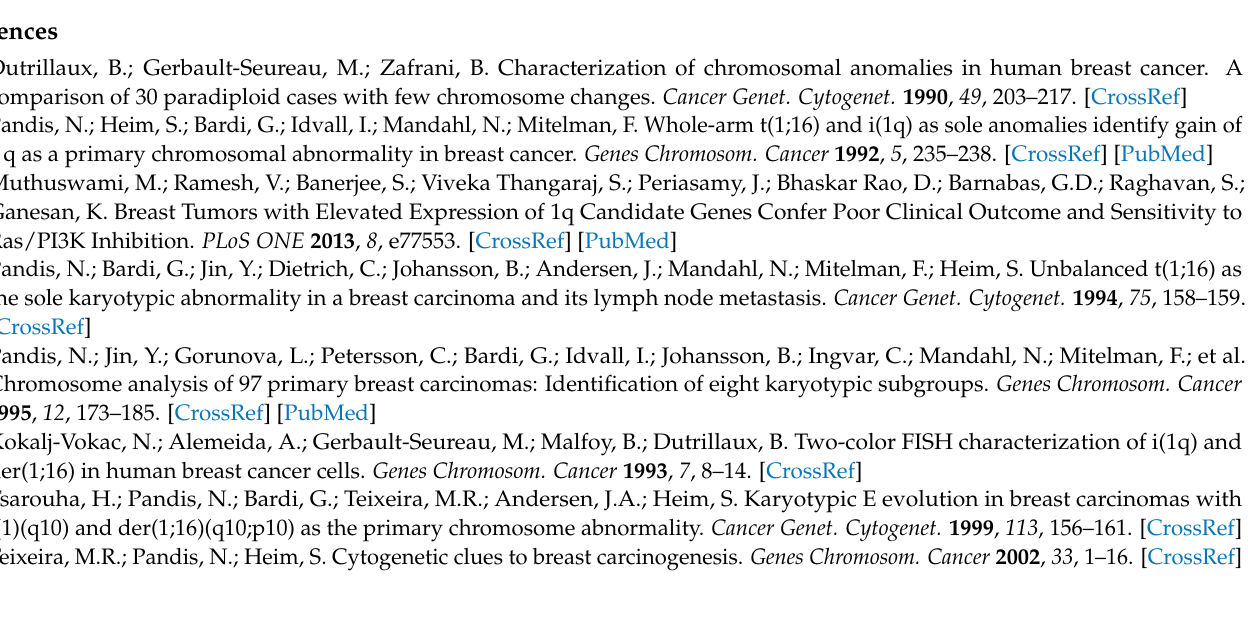
Figure S2: The normalized chromosomal distribution index (NCDI) of 1q-OverT and 16q-UnderT calculated for each cytogenetic band of a single chromosome arm, Figure S3: Values of the “modified linear FCvsCTRL” for some representative genes belonging to cluster 1, 3, and 4, Figure S4: Oncoplot showing point mutations detected by WES in 645 samples out of 709 ductal and 149 lobular BRCA samples analyzed in TCGA study, Figure S5: Oncoplots showing point mutations detected by WES in 1,16-chromogroups, Table S1: Number samples of SNP-arrays RNAseq and WES analysis, Table S2: 1q-OverUpT in all 1,16-chromogroups, Table S3: 16q-UnderT in all 1,16-chromogroups, Table S4: Metascape_result, Table S5: Analysis I and II GSEA Real Values, Table S6: Analysis I and II GSEA ABS values, Table S7: LvsD